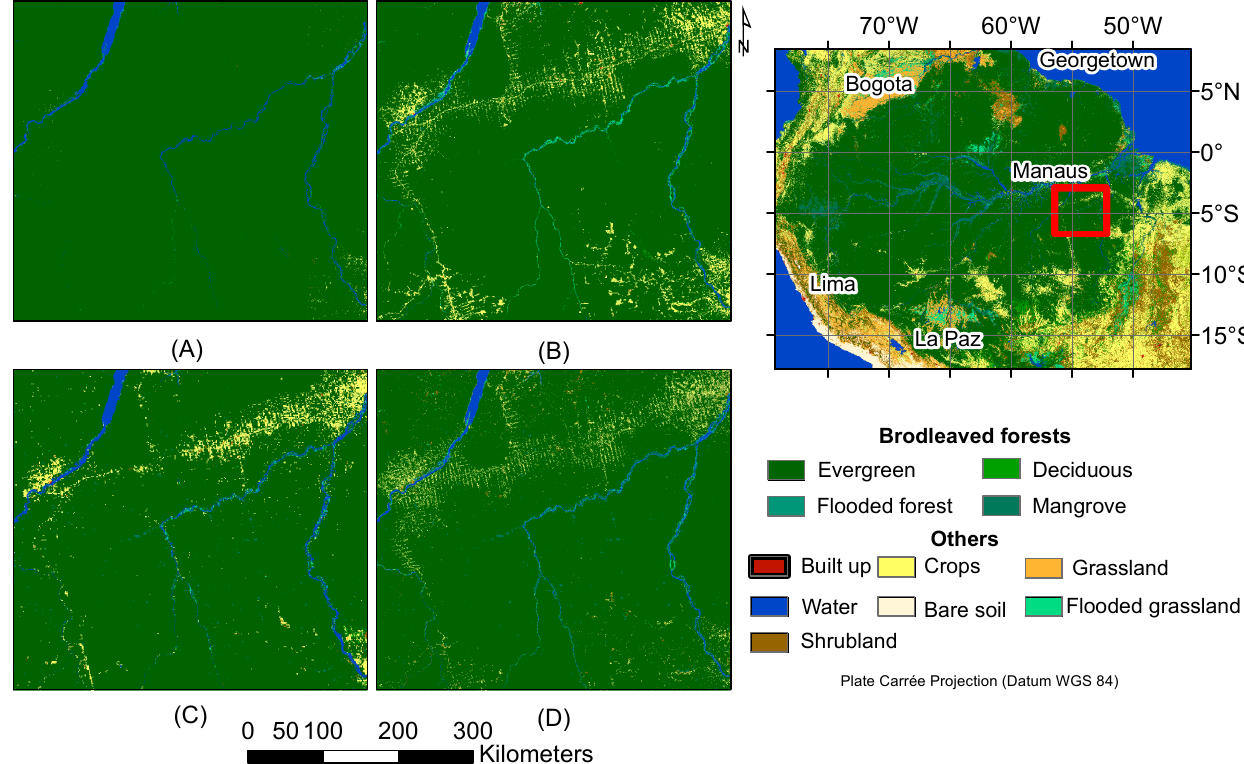
Figure 8. Classification results with ( A ) SVM and ( B ) GML in an area of the Amazon deforested between 2000 and 2010. The ( C ) training dataset (Global Land Cover (GLC) 2000) and the ( D ) Globcover 2009 products are provided for